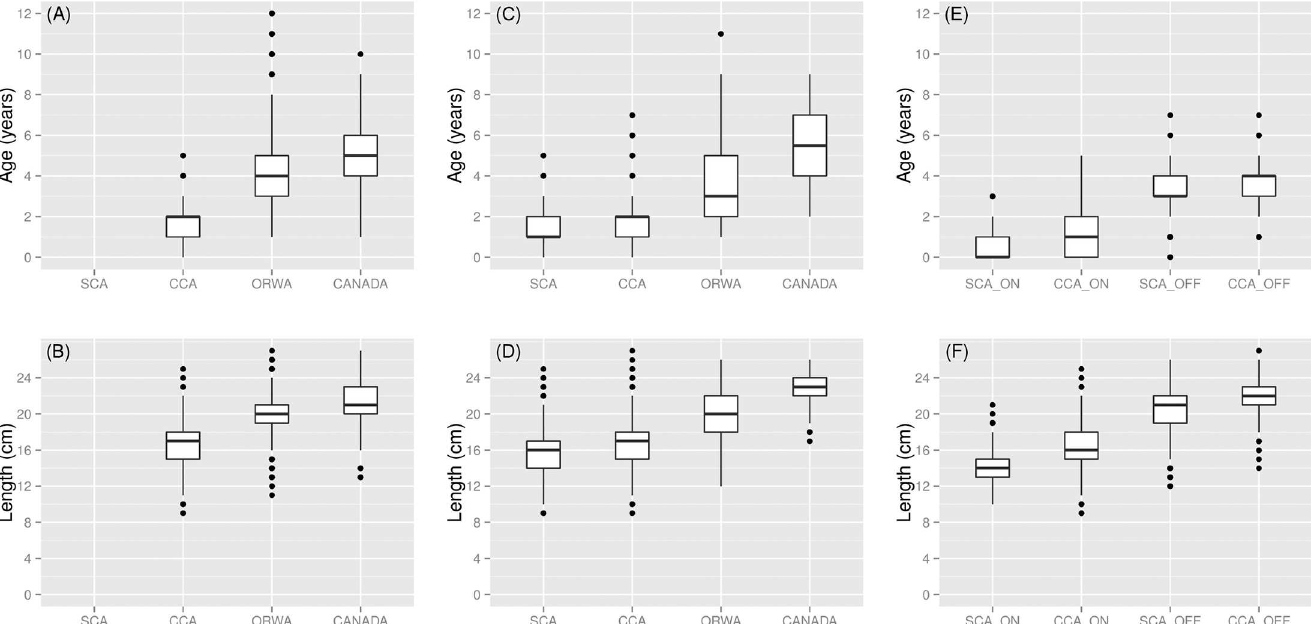
Fig 2. Boxplots of age and length by latitude during northern expansion for quarter 3 (July-September, 1981–2010)and quarter 4 (October- December, 1981–2010) and onshore-offshore during spawning (quarter 2, 2004–2010). (A) Quarter 3 age by latitude; and (B) length by latitude duringthe periodof northern expansion. (C) Quarter 4 age by latitude; and (D) length by latitude duringthe period of northernexpansion.(E) Quarter 2 age by onshore-offshore; and (F) length by onshore-offshore duringspawningin central and southernCalifornia.The horizontalline in the box represents the mean, the box represents 25th and 75th percentiles, and the dots are outside 1.5 times the interquartile range abovethe upper quartileand belowthe lower